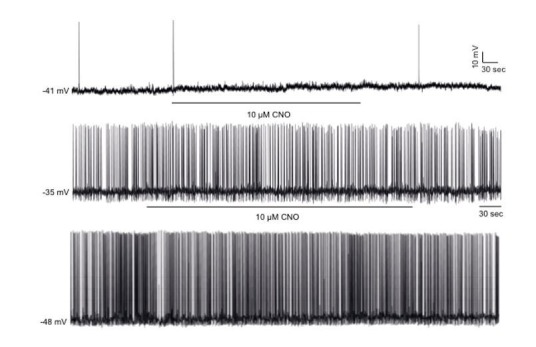
CNO has no effect of firing frequency and membrane potential in non-DREADD-expressing POMC neurons.Representative traces of whole-cell patch clamp recordings of individual hypothalamic non-DREADD expressing GFP positive POMC neurons in response to CNO (10 µM) in Pomc-Cre;Pomc-eGFP mice. CNO had no effects in all (11 cells, n=4) non-DREADD POMC neurons recorded.